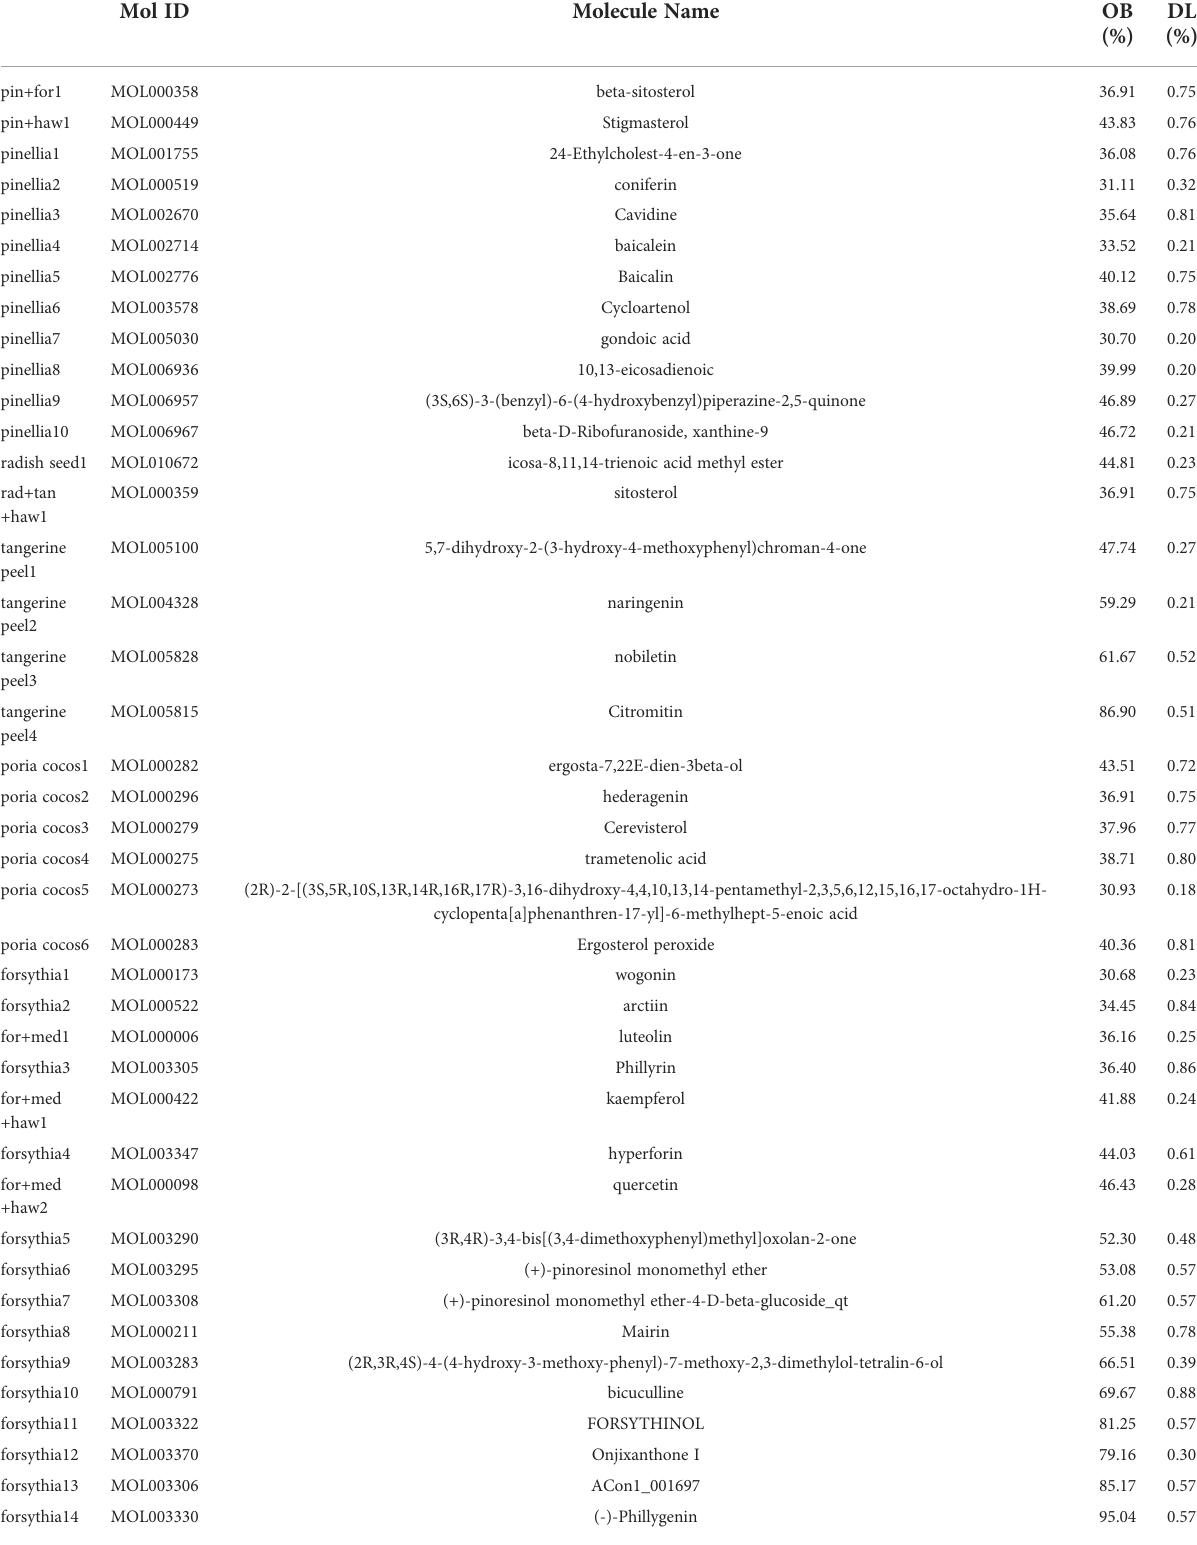
TABLE 1 Baohe pill decoction active